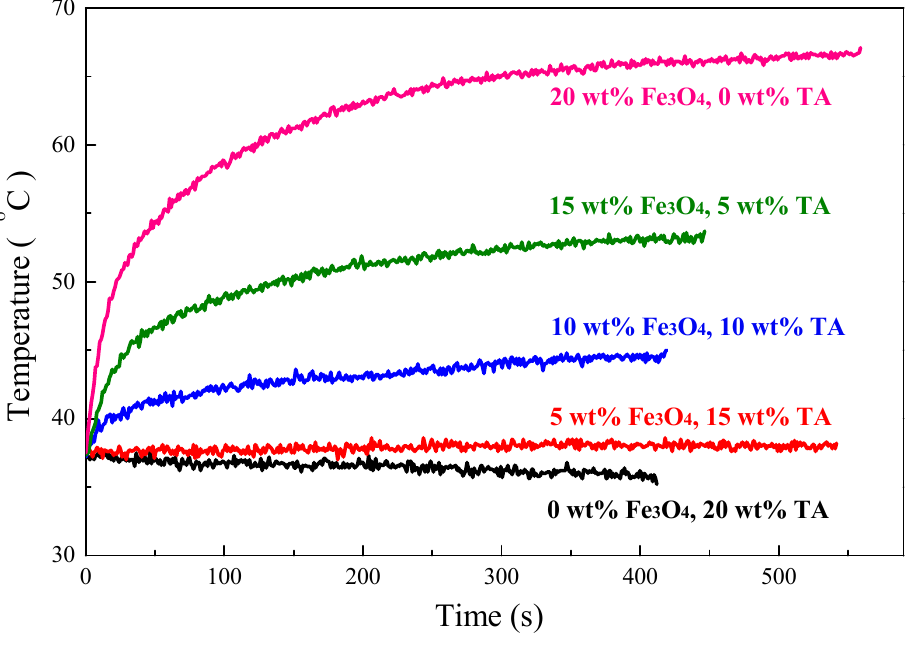
Figure 12. Heating performance of S-SEBS polymer with various amounts of TA and Fe 3 O 4 nanoparticles. Table 1. Specific absorption rate (SAR) values for S-SEBS polymer with various amounts of TA and Fe 3 O 4 nanoparticles.